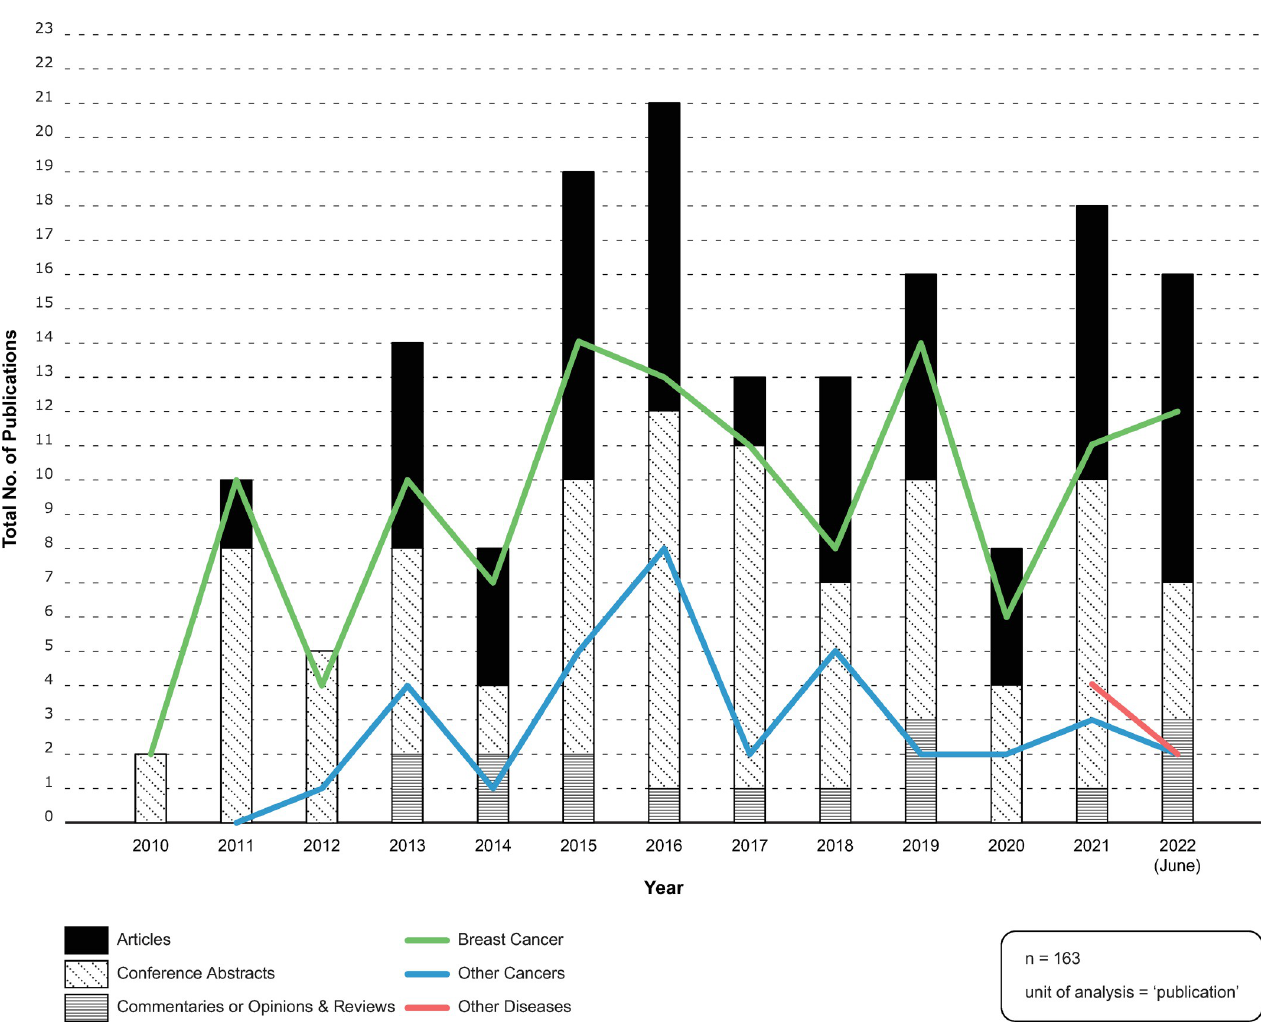
Fig 2. Publications over time. Source: Microsoft Excel: analysis; Adobe Illustrator: